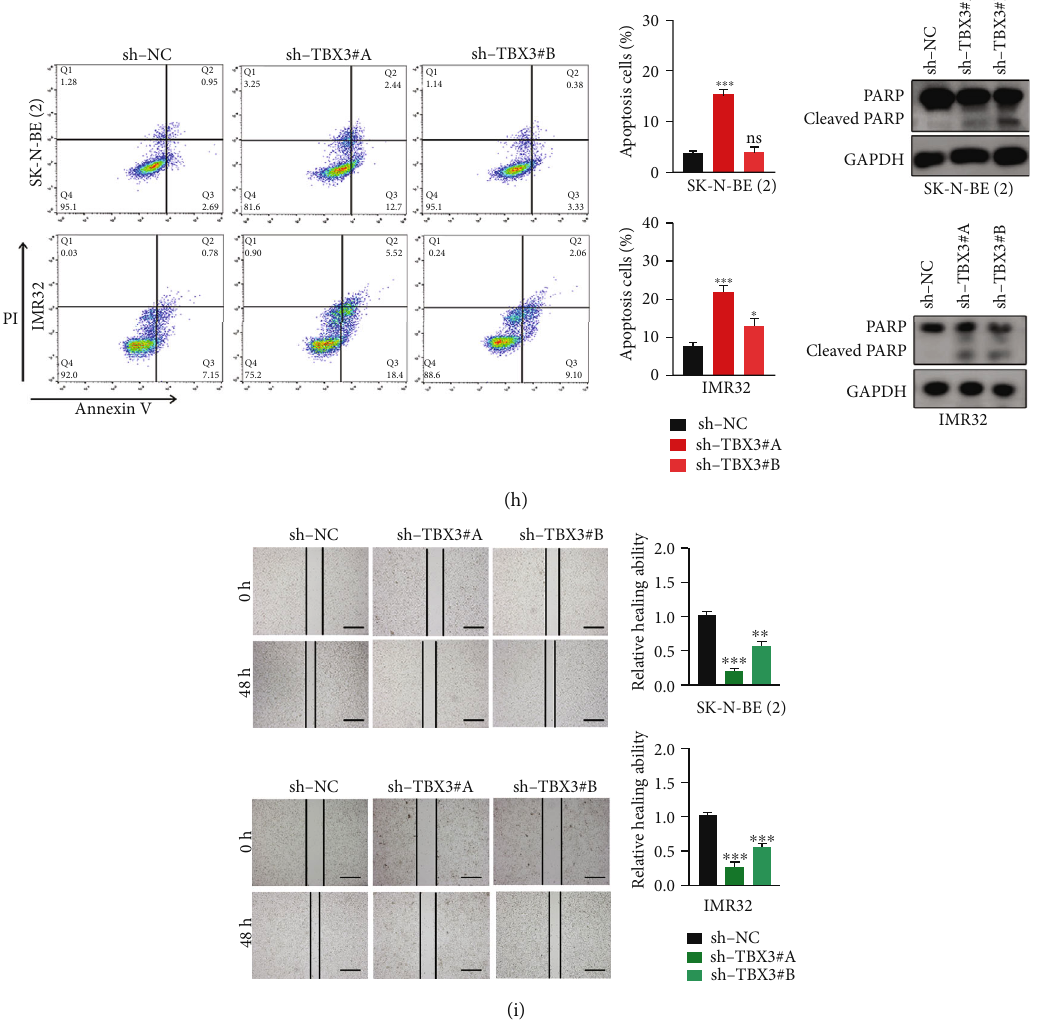
Figure 7: As a potential downstream target of dBET57, TBX3 plays an important role in NB cells. (a) TBX3 protein level decreased in a gradient-dependent manner with dBET57 concentration. (b) The IGV diagram shows the CHIP-seq spectrum of TBX3. (c) Expression of TBX3 in NB and NC cells. p value was determined by unpaired two-sided t -test. (d) Tumor pro fi le of TBX3-speci fi c expression (CCLE). In SK-N-BE(2) and IMR-32 cells. (e) TBX3 mRNA and protein expression level. (f) Cell proliferation ability of control group and experimental group. (g) Clonogenic ability of control and experimental groups. Scale bars: 4mm. (h) Apoptosis ability of control group and experimental group. (i) Migration ability of control and experimental groups. Scale bars: 100 μ m. Each sh-TBX3 group was compared with the sh-NC group. ∗ p < 0 : 05 , ∗∗ p < 0 : 01 , and ∗∗∗ p < 0 : 001 ; ns: not signi fi